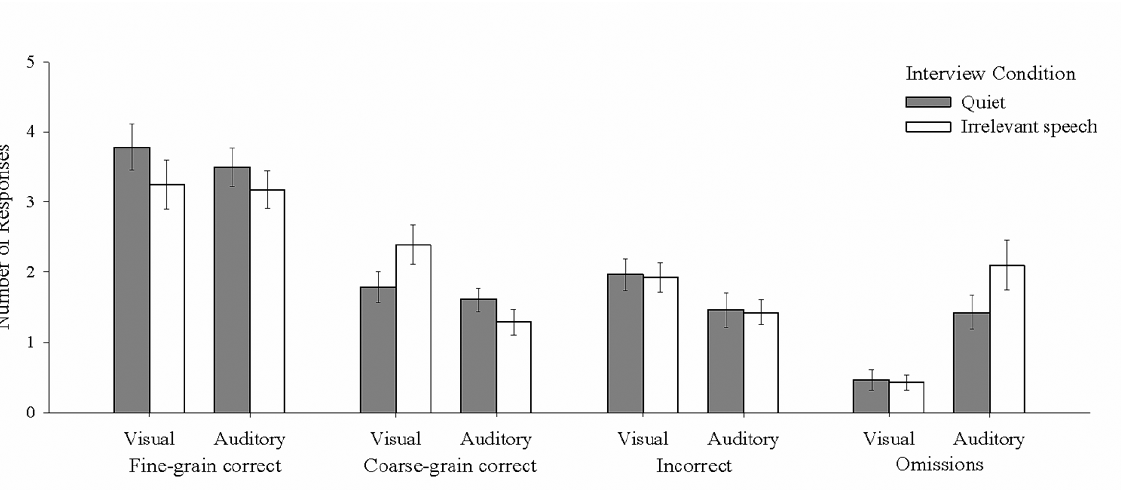
Mean number of fine-grain correct, coarse-grain correct, incorrect, and omitted responses about visual and auditory aspects of the witnessed event in Experiment 2. Error bars indicate standard